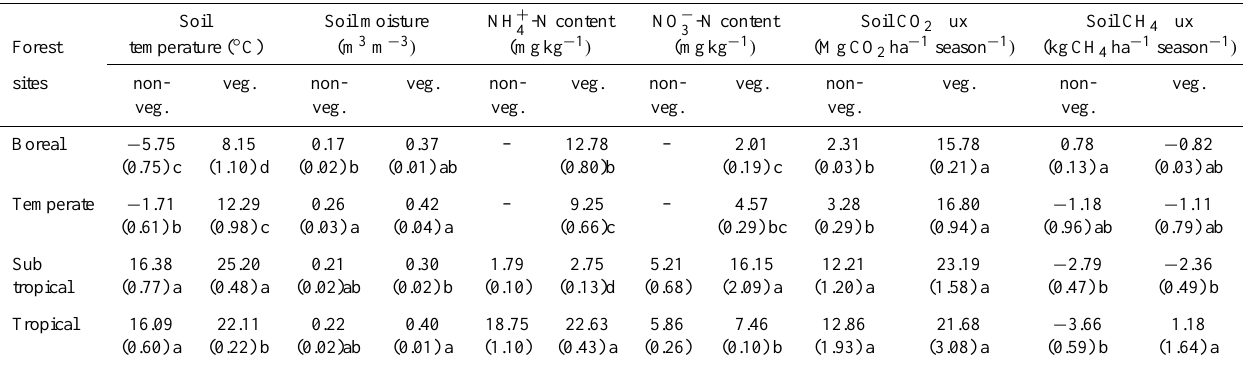
* Vegetative season is from May to October and non-vegetative season is from November to April next year. Negative CH 4 values are CH 4 uptake. Means followed by different letters in the same column are significantly different (Turky’s HSD comparison).